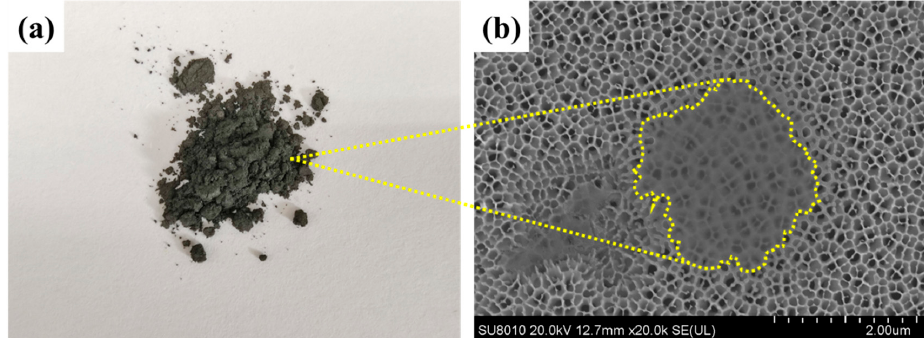
Figure 3. ( a ) MXene (Ti 3 C 2 T x ) powder, ( b ) FESEM image of the MXene nanosheet on an anodized aluminum oxide (AAO).